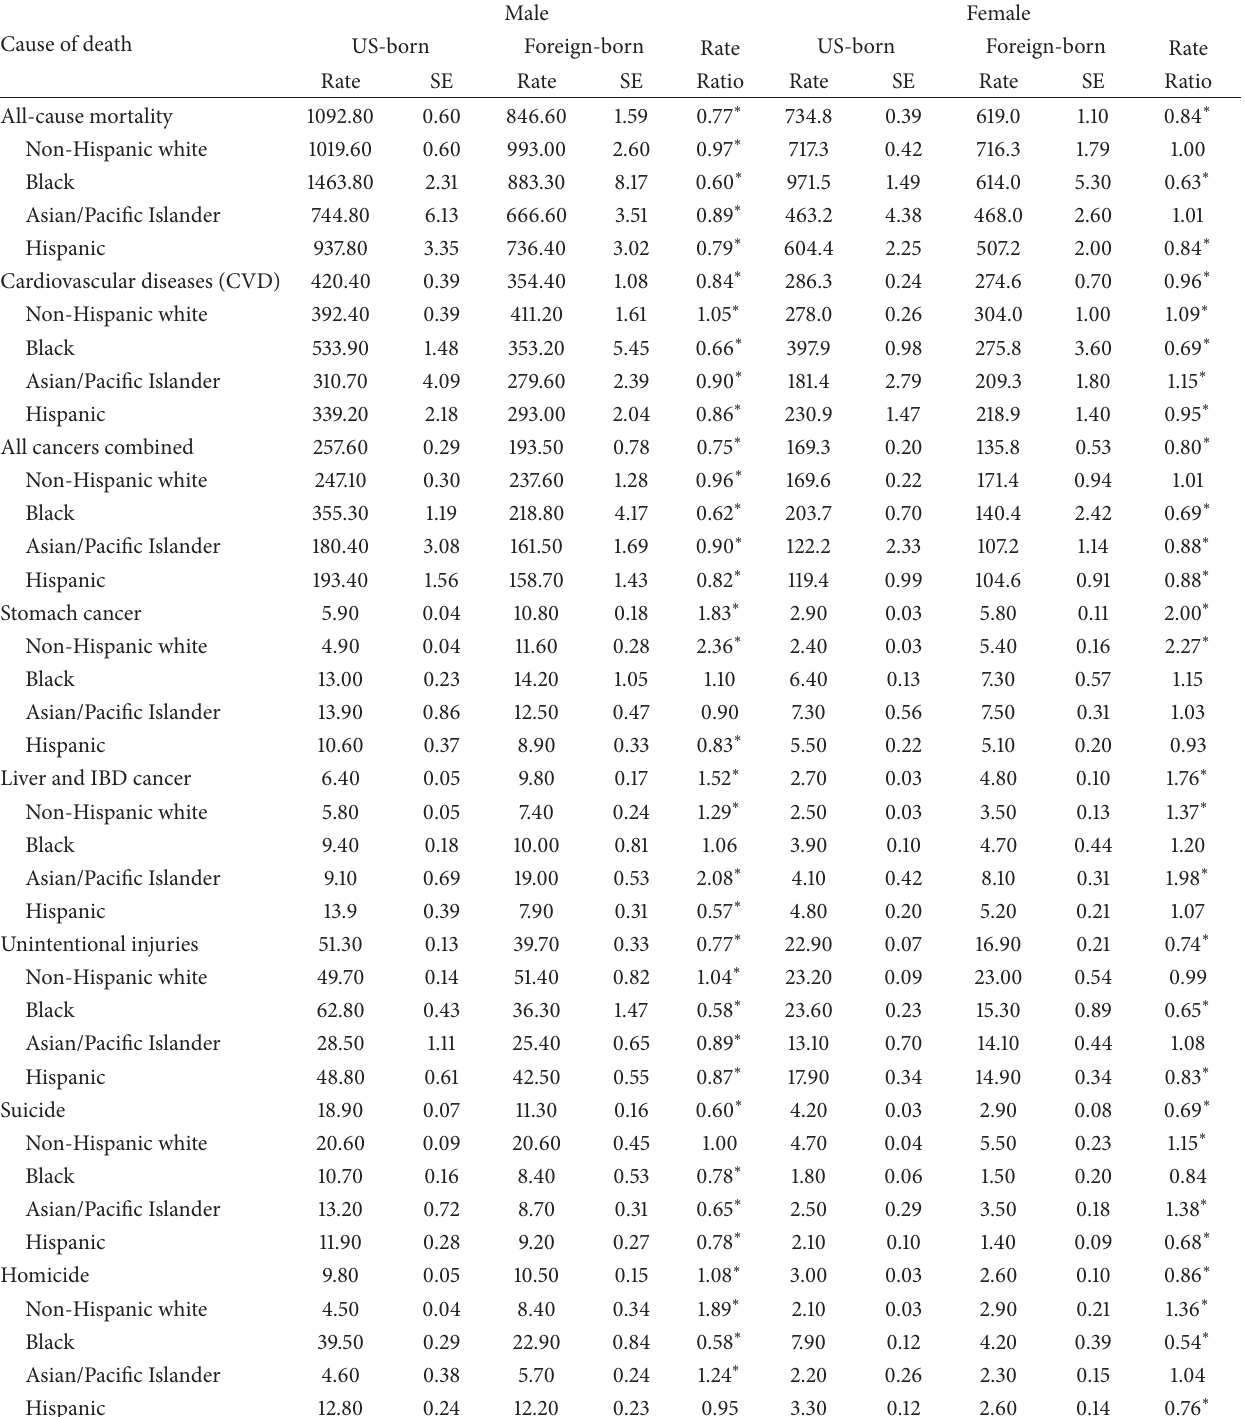
Table 2: Average annual age-adjusted death rates for selected major causes of death by nativity/immigrant status, United States, 1999–2001. Cause of